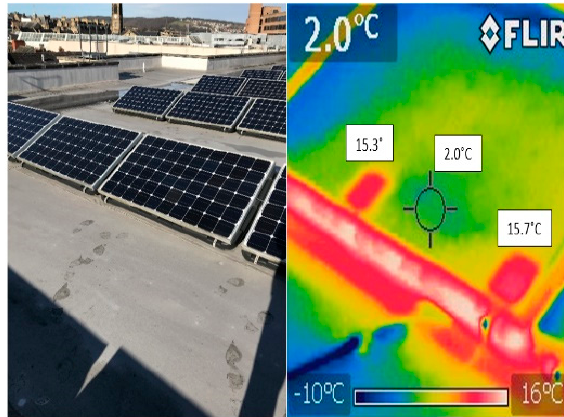
Figure 2. The experimental result of observing hotspots in a PV module. The temperature of the hotspots is nearly 13 degrees higher than adjacent non-hot-spotted solar cells [15].